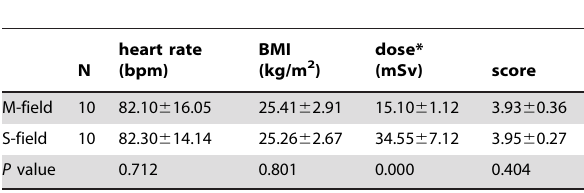
Table 6. Comparison of results from M-field scanning and S- field scanning in the premature beat